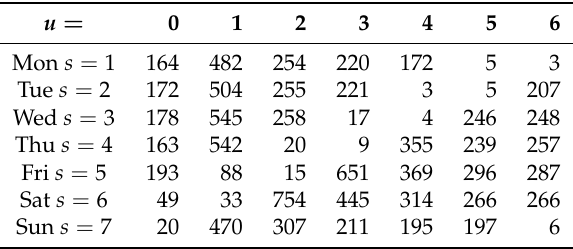
Table 2. Observed number of reported claims M (cid:48)(cid:48) s , u ( τ m ) for weekdays 1 ≤ s ≤ 7 and reporting delays 0 ≤ u ≤ 6 = u ( 1 ) − 1 at time τ m = 31/10/2010 for claims with accident dates before 26/10/2010 of LoB Property.